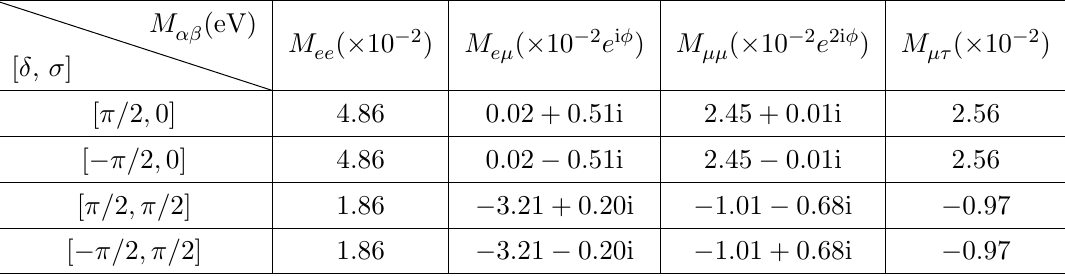
for various combinations of (cid:14) and (cid:27) in the IH case. (cid:11)(cid:12)